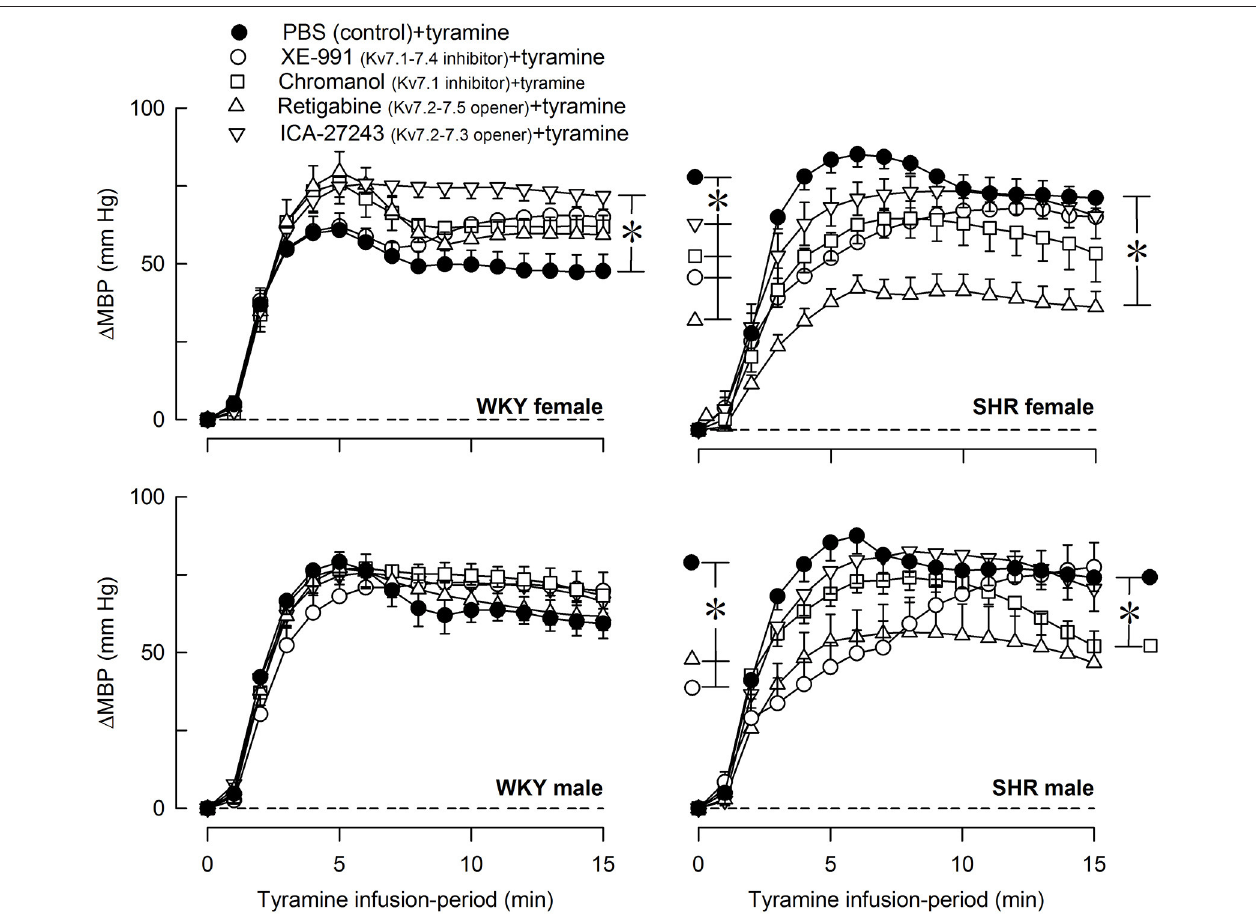
FIGURE 9 | The effect of Kv7 inhibitors/openers on the MBP-response to tyramine-stimulated norepinephrine release. The rats were pre-treated as indicated by symbol legends. Differences between the control and the drug-treated experimental groups at the time of the initial TPR-peak-response, i.e., at 4min (*within brackets left of curves), and at 15min (*within brackets right of curves) were detected as indicated, using two-sample Student’s t -tests or Kruskal–Wallis tests after curve evaluation with Repeated Measures Analyses of Variance and Covariance. The MBP-response at these times was significantly different from baseline in all groups (not indicated). In the order of symbol legends, MBP prior to tyramine = 56 ± 3, 61 ± 3, 56 ± 2, 44 ± 2 ‡ , 59 ± 3 mm Hg, 57 ± 3, 50 ± 6, 42 ± 5, 42 ± 2, 49 ± 4 mm Hg, 57 ± 2, 63 ± 3 ‡ , 62 ± 3, 51 ± 2, 58 ± 3 mm Hg, and 69 ± 4 † , 59 ± 7, 69 ± 9, 55 ± 5, 67 ± 6mm Hg in female WKY and SHR and male WKY and SHR sets of groups, respectively ( P ≤ 0.0125 for strain- (*), sex- ( † ), or drug- ( ‡ ) related differences in the baselines). * P ≤ 0.025 (please see the Materials and Methods section for